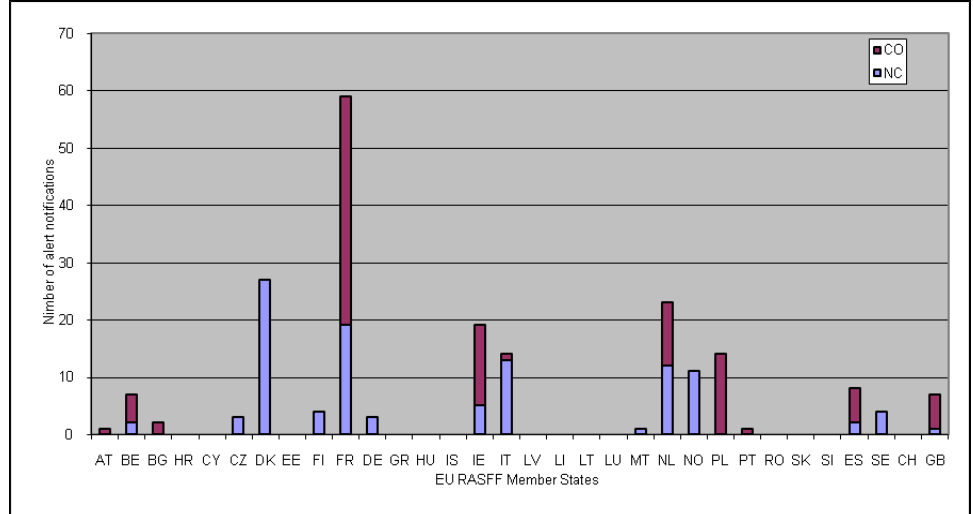
Figure 1. The European Union Rapid Alert System for Food and Feed (EU RASFF) members acting as notifying countries (NC) and countries of origin (CO) for “norovirus”-related alert notifications